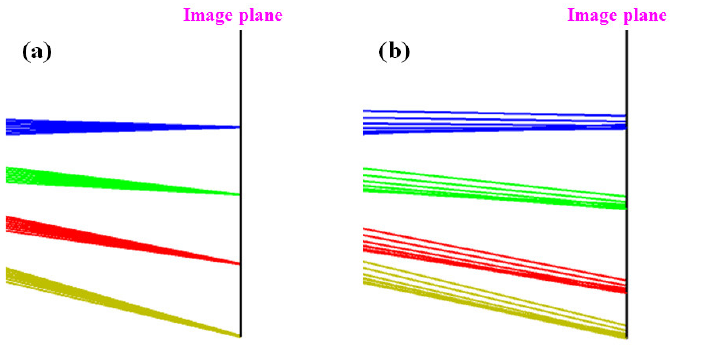
Figure 6. Light ray propagated in the initial optical endoscope ( a ) and optical endoscope with phase mask ( b